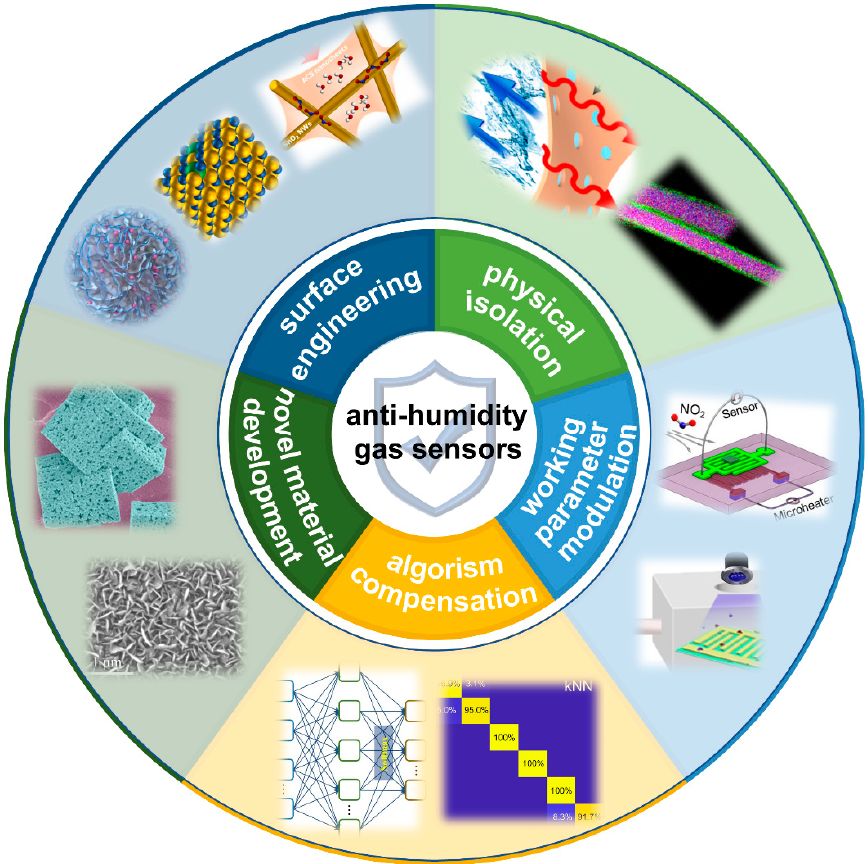
Figure 2. An overview of the anti-humidity strategies of gas sensors, adapted from [41–51]. As stated above, water vapor affects the sensor performance in terms of base resistance and response when humidity changes. Therefore, the coefficient of response variation (CV), baseline resistance drift, baseline resistance ratio, response drift, and response ratio are the widely-accepted criteria to evaluate the performance of anti-humidity effect, and are defined as Equations (2)–(6), respectively: